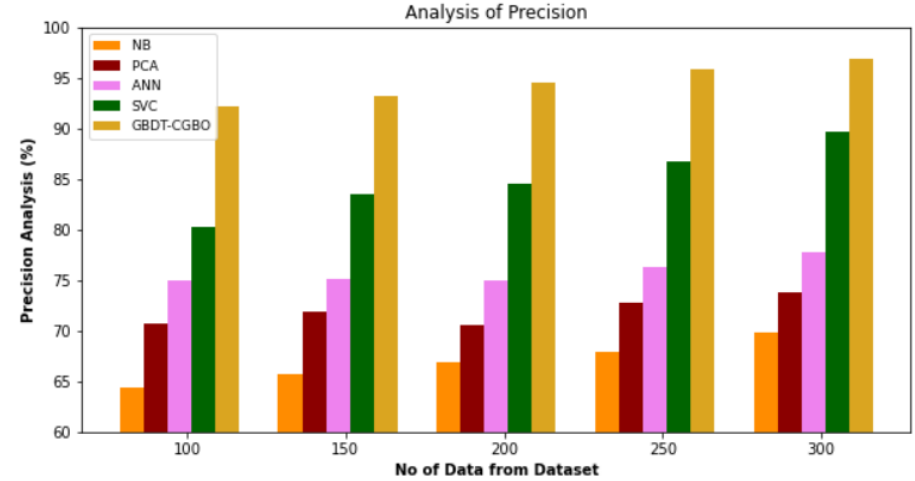
Figure 2. Precision Analysis of GBDT-CGBO method with existing system. Table 1. Precision Analysis of GBDT-CGBO method with existing system in percentage.